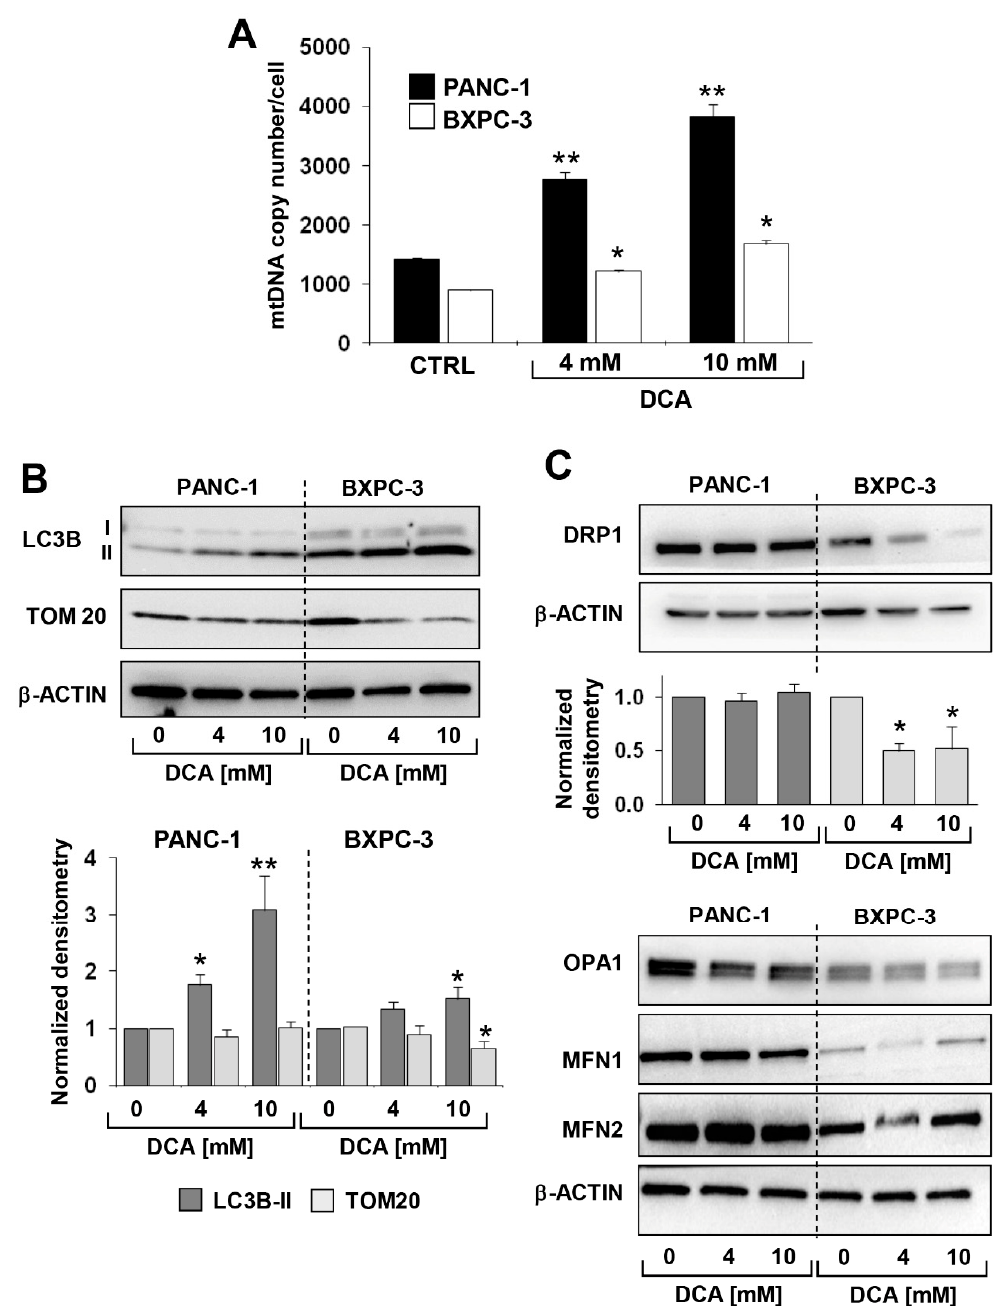
Figure6. E ff ectofDCAonmitochondrialbiogenesis, mitochondrialdynamicsandmitophagyinPANC-1 and BXPC-3 cell lines, ( A ) mtDNA copy number assessed by q-RT-PCR, the bar histogram shows values normalized to the nuclear DNA and are the means ± SEM of three independent experiments (* p < 0.05 vs. PANC-1 CTRL, ** p < 0.05 vs. BXPC-3 CTRL); ( B ) representative immunoblotting for protein expression levels of LC3B and TOM20 in PANC-1 and BXPC-3 treated with DCA and densitometric analysis (lower histogram) performed for three independent experiments and expressed as mean ± SEM (* p < 0.05, ** p < 0.05 vs. respective CTRL 0 mM DCA); ( C ) representative immunoblotting for protein expression of factors involved in mitochondrial fission (top panel) and fusion (bottom panel), upper panel shows a representative immunoblotting for protein expression level of DRP1 with densitometric analysis (* p < 0.05 vs. CTRL-0 mM DCA), lower panel shows a representative immunoblotting for OPA-1, MFN1, MFN2, and the β −